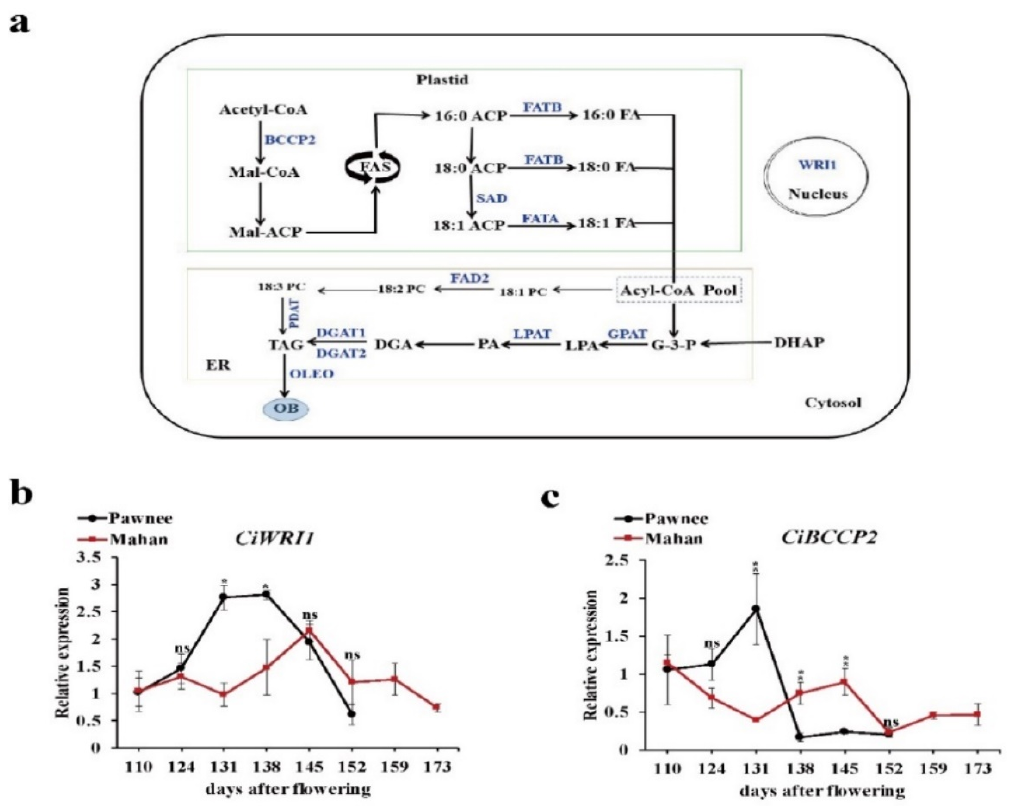
Figure 2. Expression patterns of genes involved in FAs biosynthesis in pecans. ( a ) Working model of triacylglycerol (TAG) biosynthesis pathway in plants. OB, oil body. ( b , c ) Expression levels of CiWRI1 ( b ) and CiBCCP2 ( c ) in different pecan varieties quantified by quantitative reverse transcription polymerase chain reaction (qRT-PCR) with three biological replicates. The Carya illinoinensis ACTIN gene was used to normalize target mRNA levels. Primers used for qRT-PCR are listed in Table S1. * p < 0.05, ** p < 0.01; ns, no significant difference.